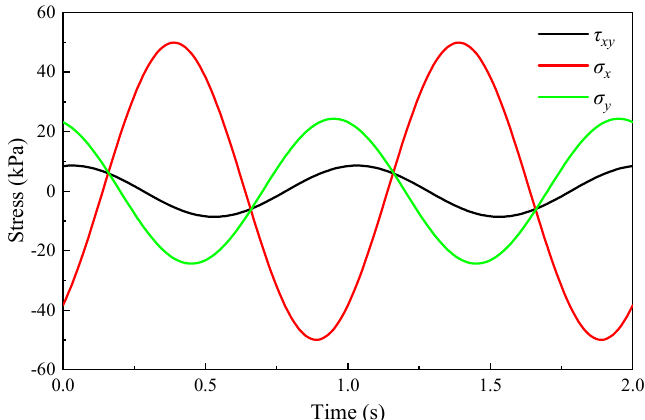
Figure 3. A typical time history for three dynamic stress components under incident P- and SV-waves ( α = 30 ◦ , f = 1 Hz, µ = 0.4, vs. = 200 m/s, ϕ = 0 ◦ , z = 10 m; these symbols will be explained later).